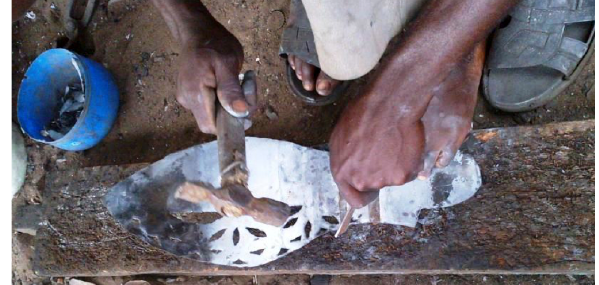
Figure 7 | Cutting out traced patterns on a traditional sword with a chisel made from carbon steel strip. Photograph by Kingsley O. Emeriewen,